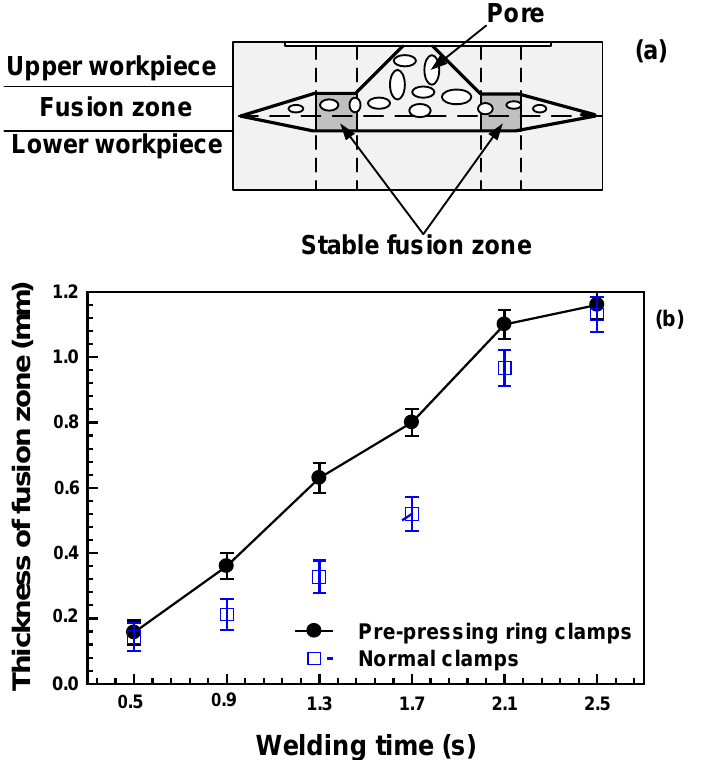
Figure 11. Schematic of stable fusion zone ( a ) and the correlation between the weld time and thickness of fusion zone with two kinds of clamps ( b ).